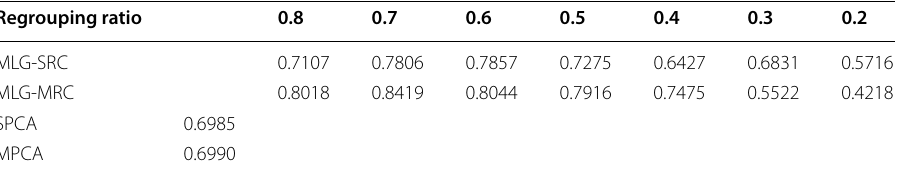
spectra calculation (Seconds) + # of matrices/ tensors